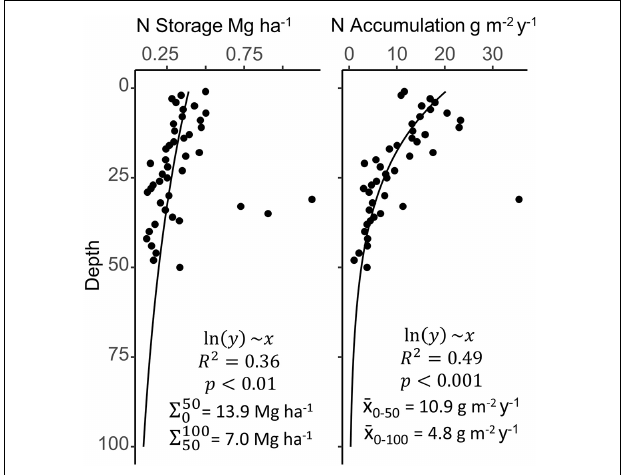
FIGURE 6 | Mean depth profiles for nitrogen (N) storage and accumulation across all sites, with the deepest layers approximated by extrapolation of a log transformed linear model. Filled circles are combined mangrove soil data from nine San Juan Bay Estuary cores. Site-specific depth profiles (not shown) varied greatly and may not necessarily follow the estuary-wide